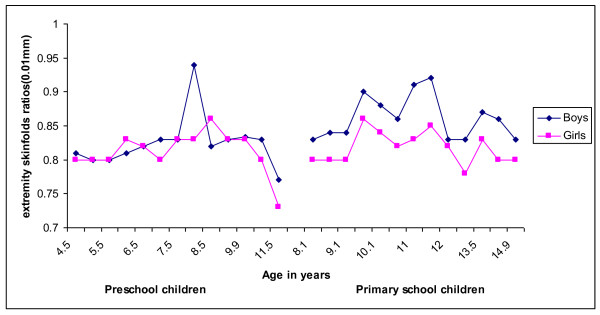
Development of median subscapular/triceps skinfild ratio of Ellisras rural children.